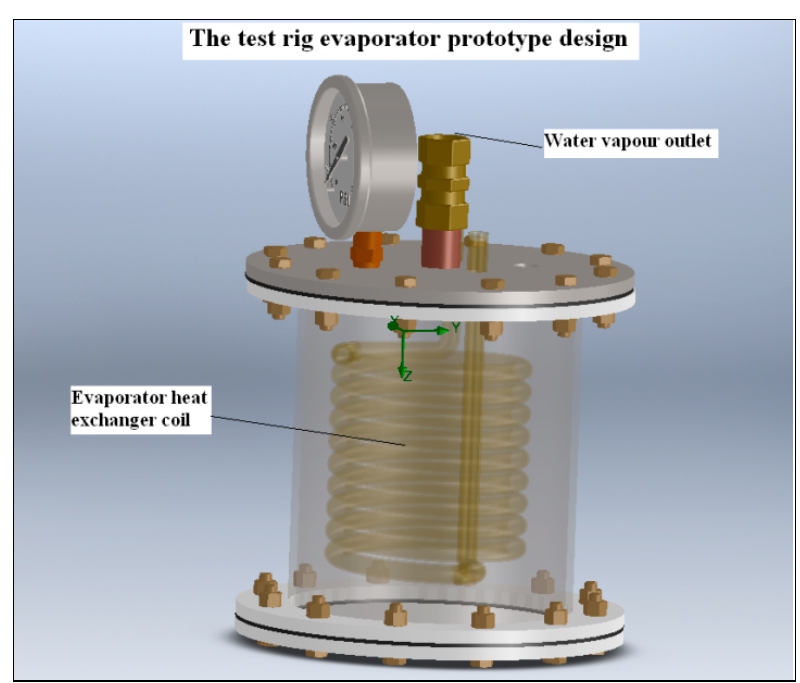
Computation 2016 , 4 , 8